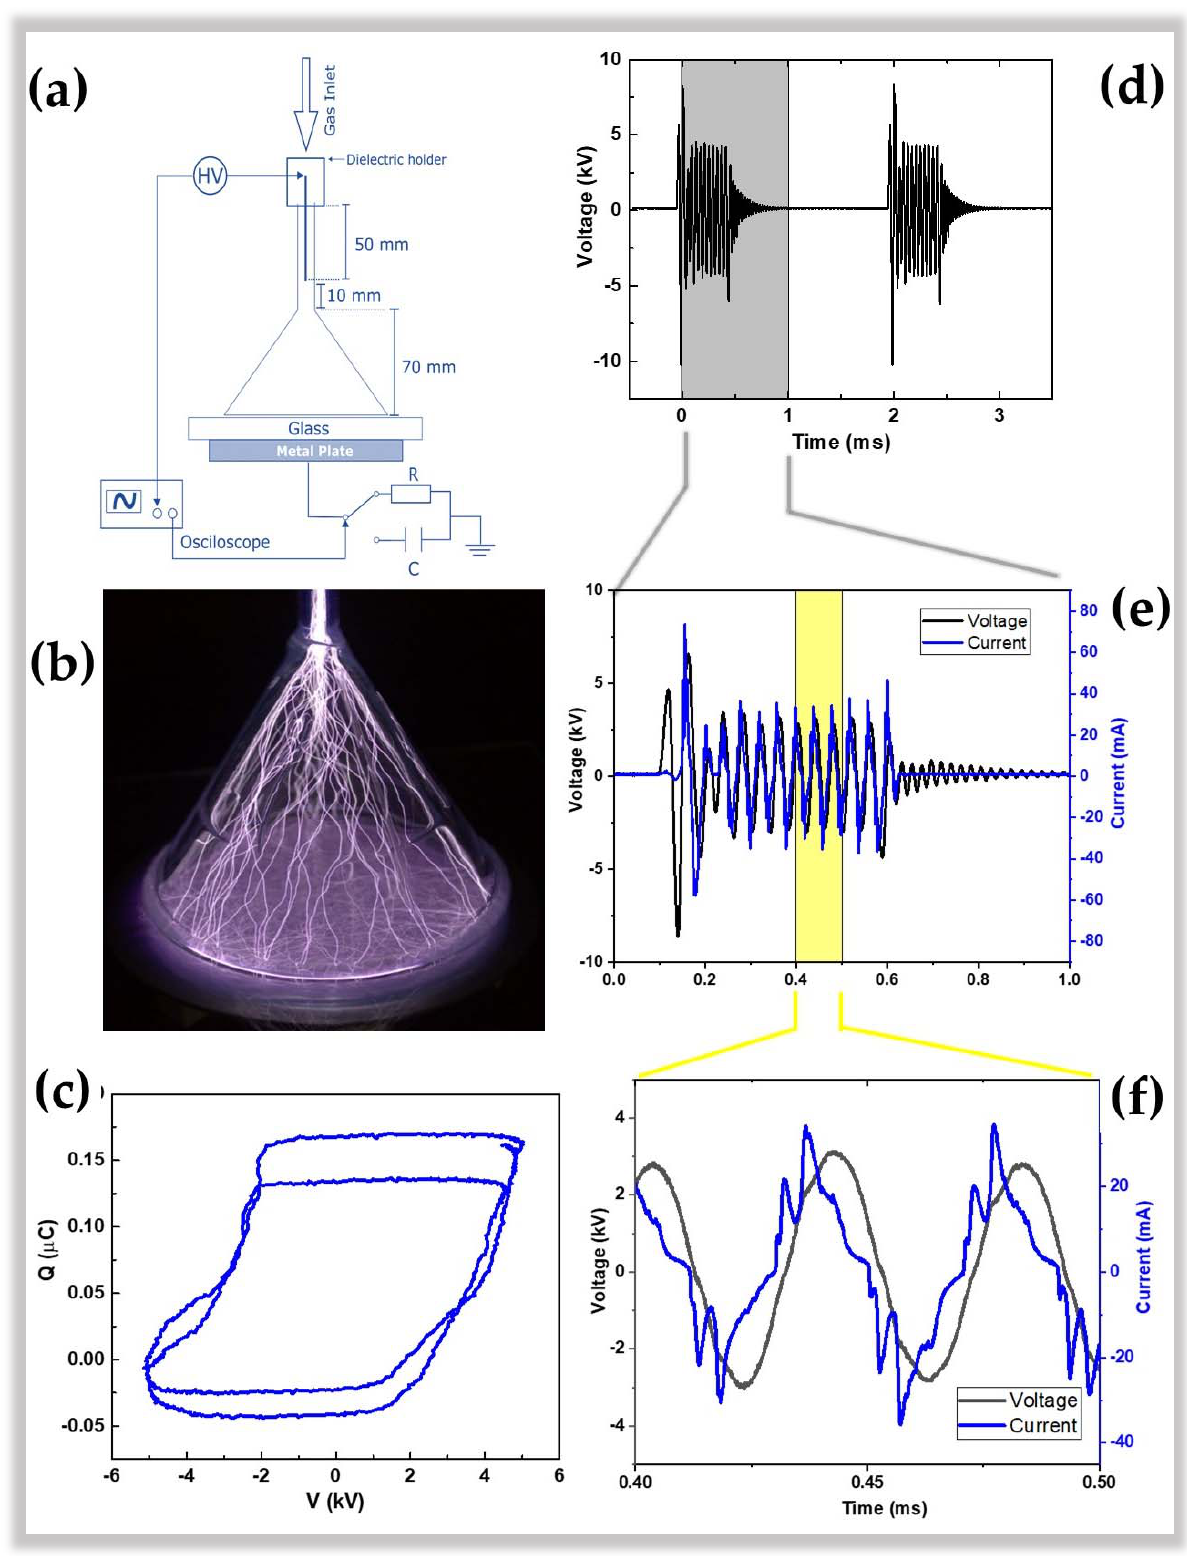
Figure 1. ( a ) Schematic layout of the conical-shaped atmospheric pressure plasma jet (CS-APPJ) system; ( b ) Photo of the filamentary discharge inside the conical horn; ( c ) Lissajous Figure (Q × V). Overview of typical electrical parameters of ( d ) applied voltage; ( e ) voltage and current waveforms in a full burst of 12 high-voltage oscillations; ( f ) in two wave periods from the middle of the burst signal.